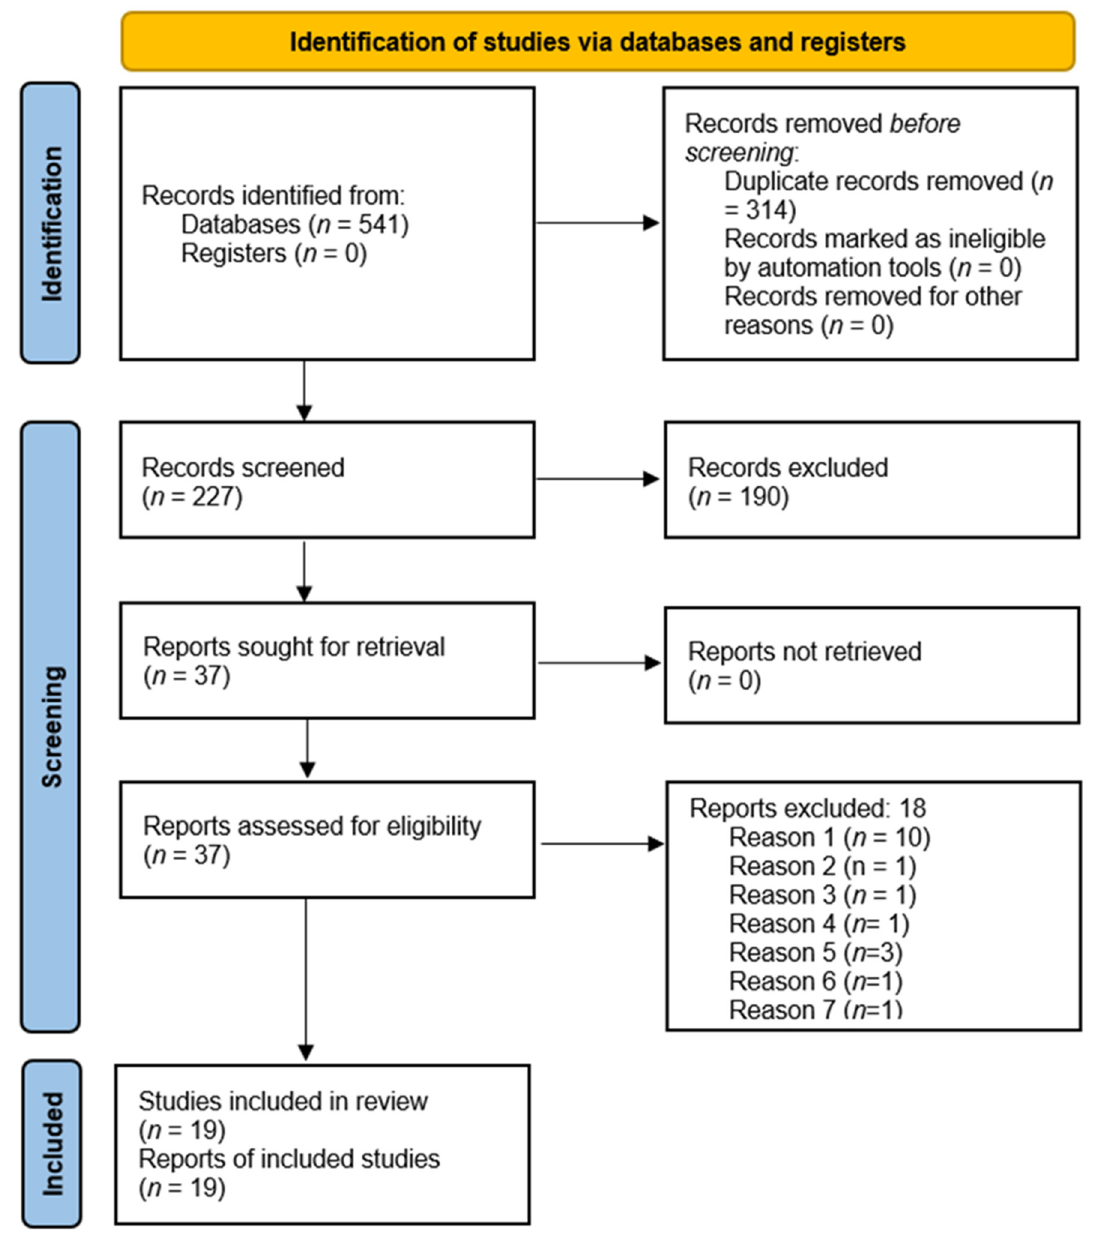
Figure 2. PRISMA study flow